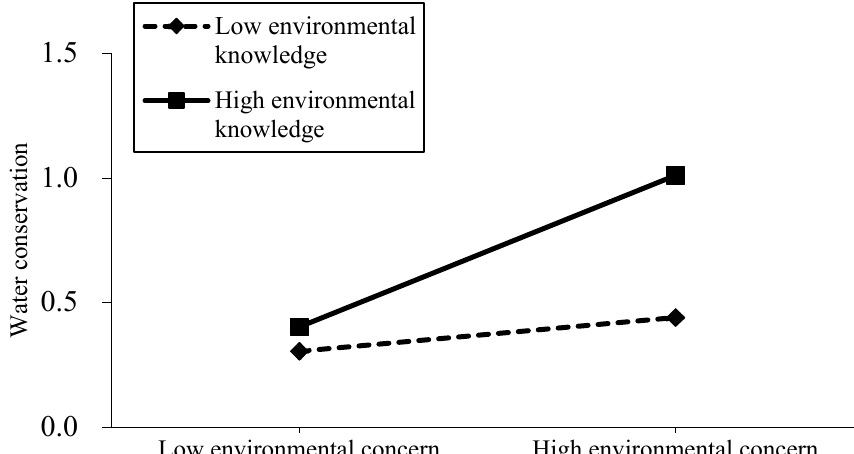
Figure 2. The moderating effect of environmental knowledge on the relationship between environ- mental concern and water conservation behavior.